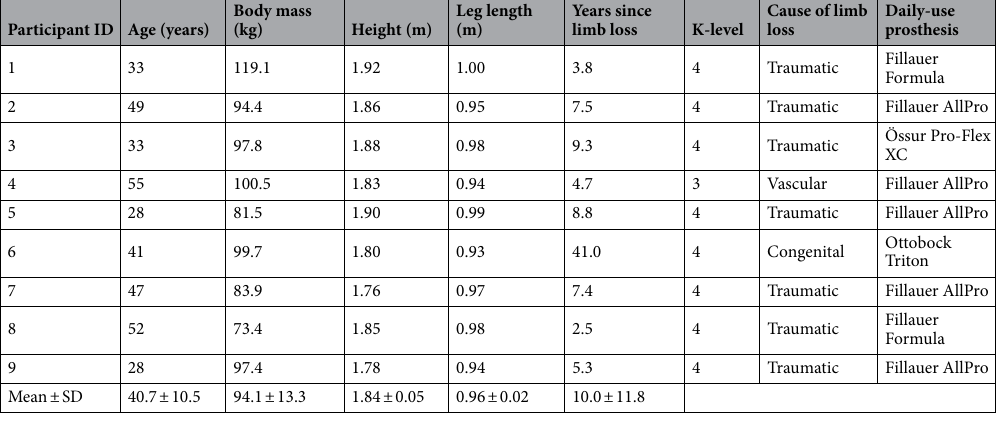
Table 1. Participant